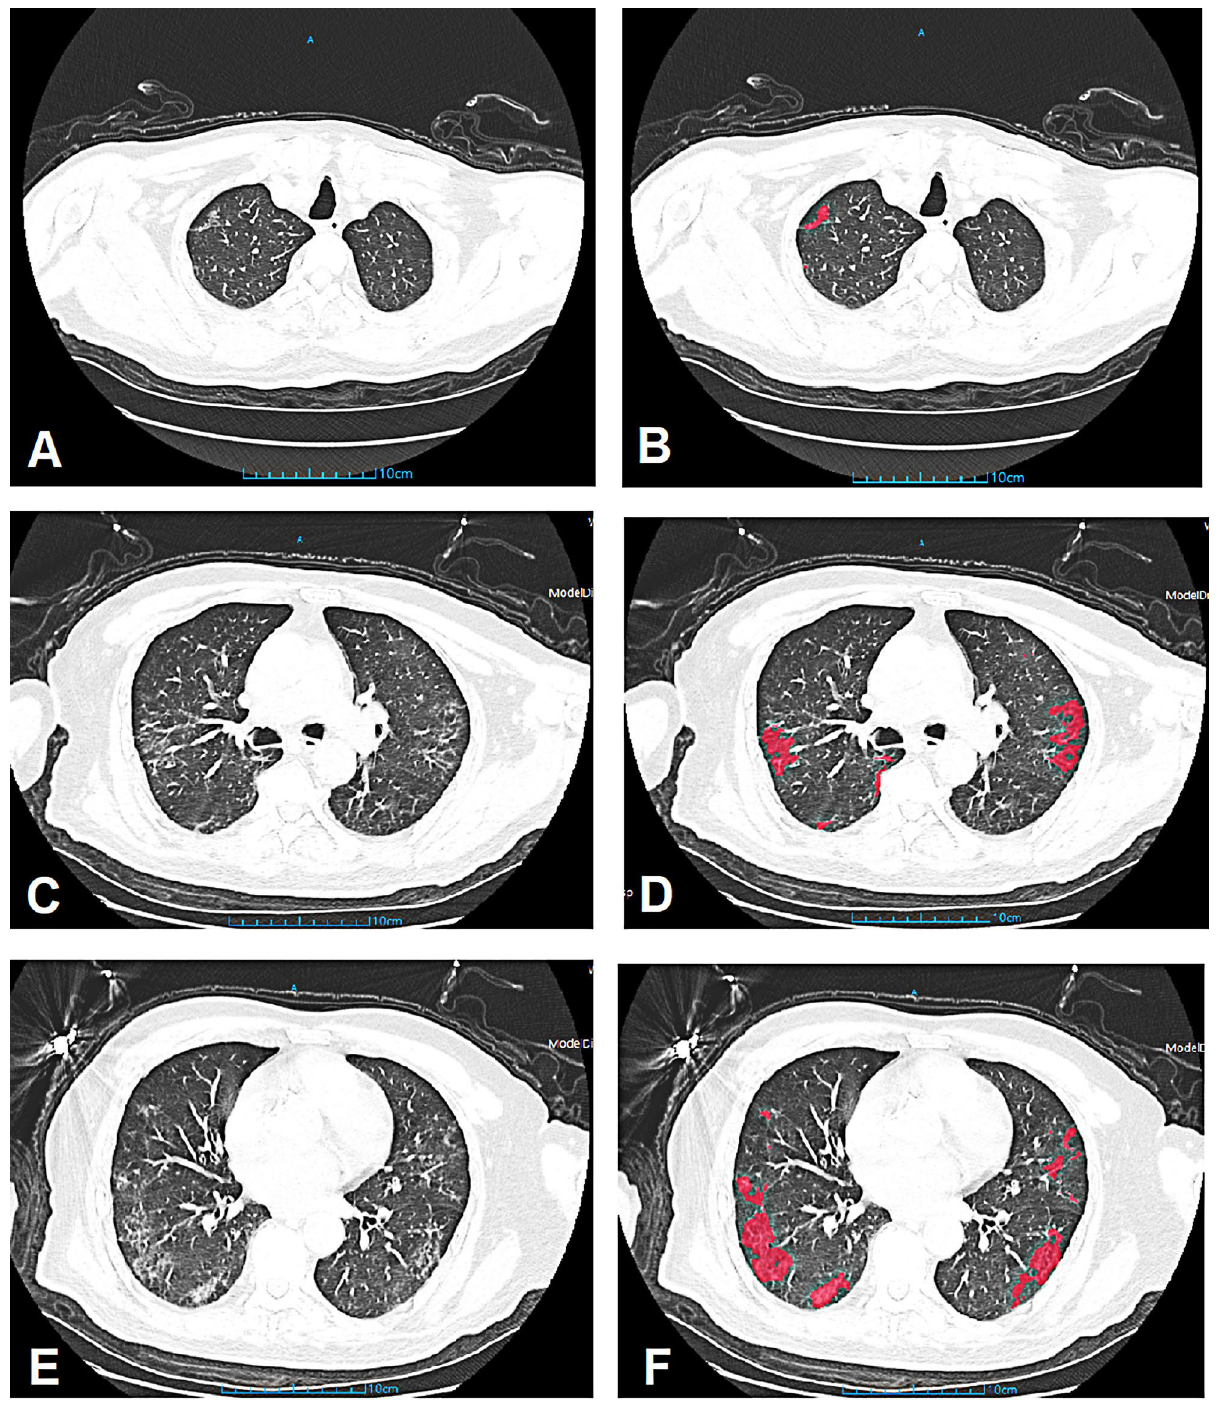
Figure 2. Representative case of a 78-year-old male patient with COVID-19 from non-severe group. Initial chest CT on admission showed multiple GGO lesions from upper ( A , B ), middle ( C , D ) and lower ( E , F ) zones. The CT severity score was 6. The GGO volume and GGO volume percentage were measured as 103.93 cm 3 and 3.09%. COVID-19 Coronavirus disease 2019, CT computed tomography, GGO ground glass